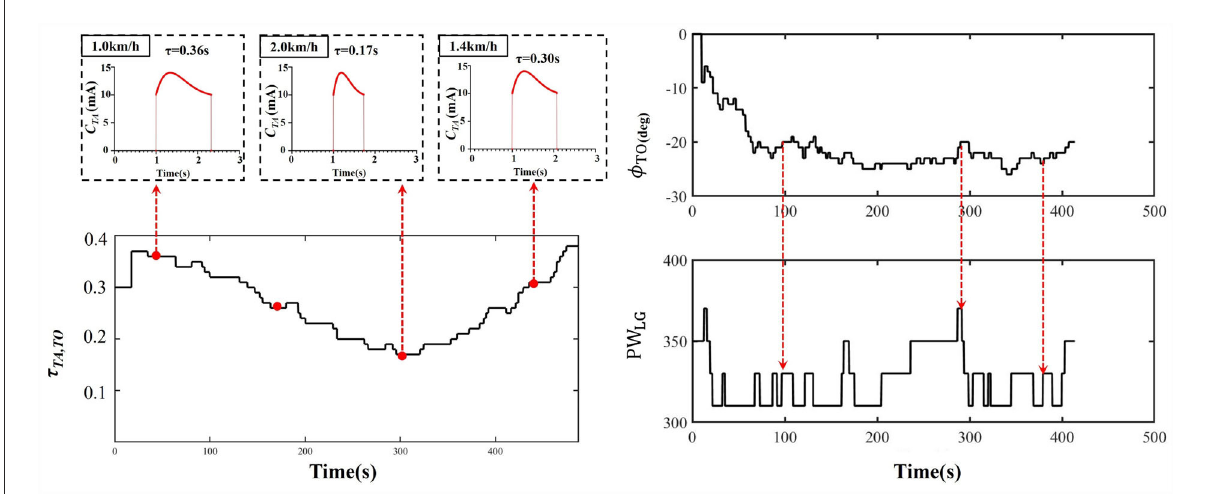
FIGURE6 An example of the time constant coefficient τ TA , TO of TA muscle and pulse width (PW) of LG muscle over in a trial of one participant with walking speed varying from 1.0 to 2.0km/h.